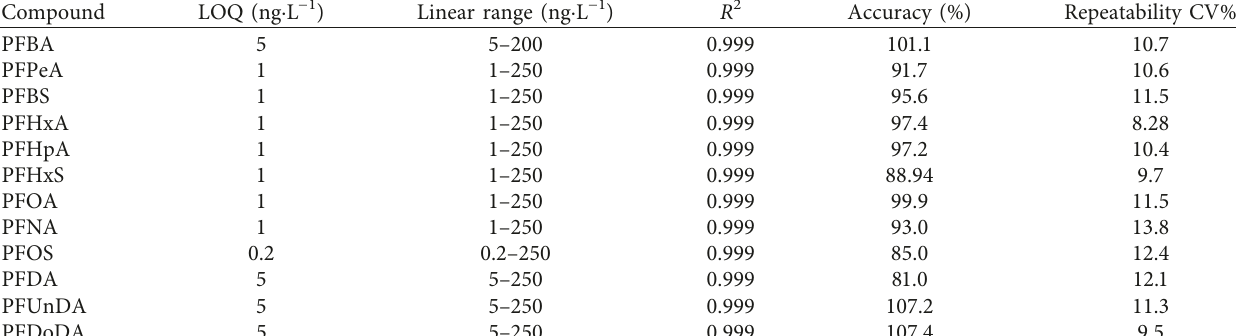
Table 5: Limits of quantification (LOQs), linearity range, R2, accuracy, and repeatability parameters evaluated at